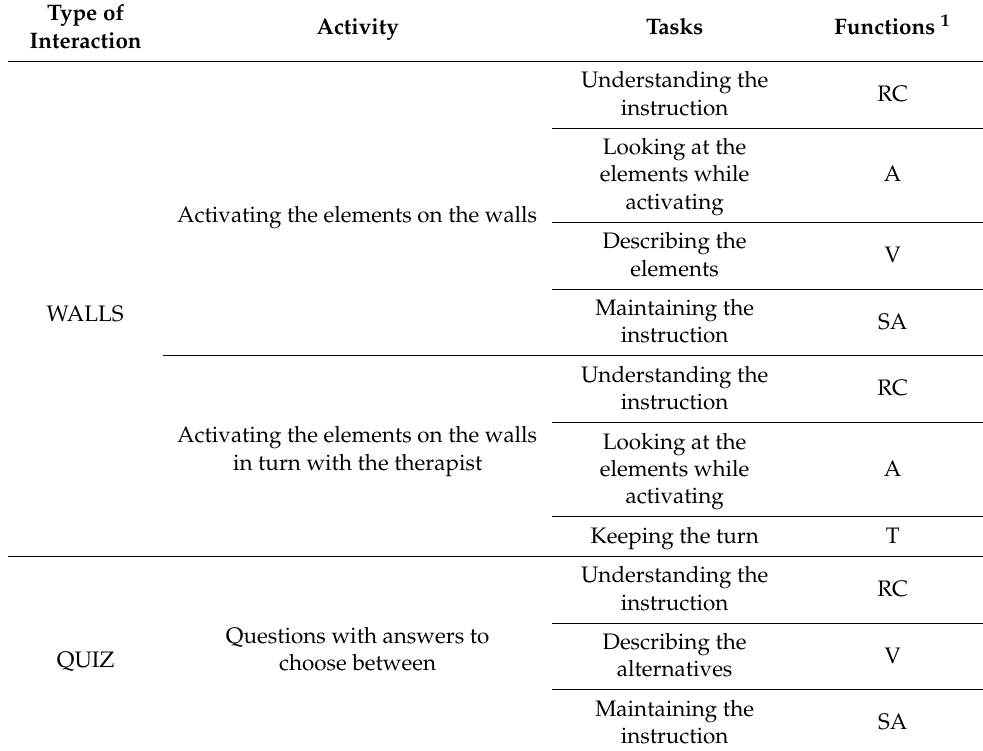
Table A1. Cont. Type of